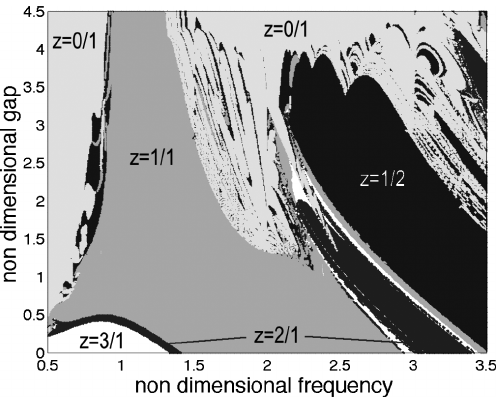
Fig. 13. Regions of stable periodic